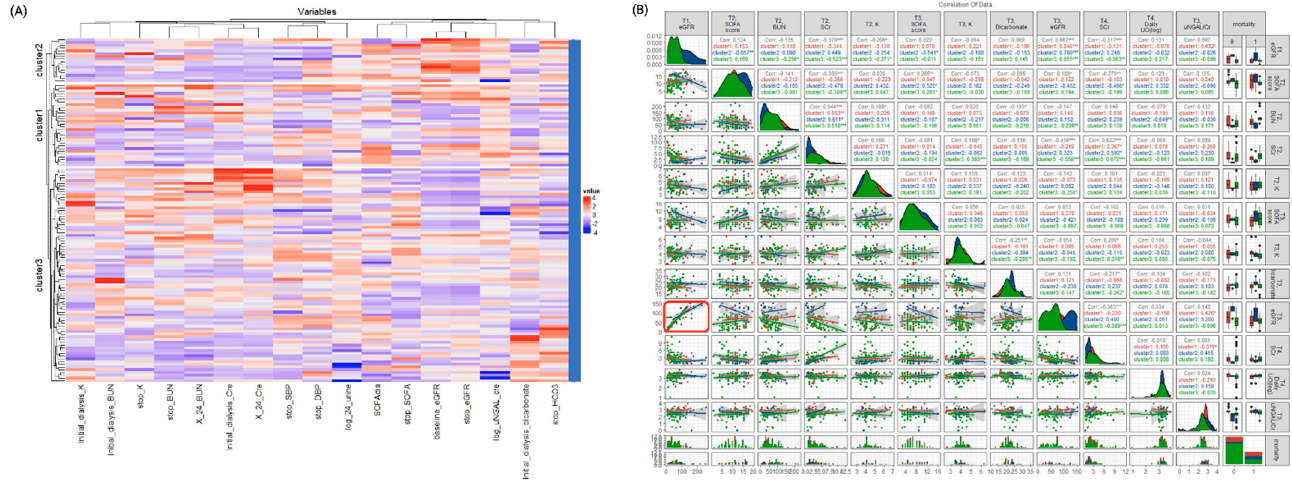
Figure 2. ( A ) The heatmap shows the three subtypes according to the selected baseline parame- ters. The dendrogram on the y axis shows consensus clustering of the patients. The x axis shows the variables of the patients attempting to wean from RRT. ( B ) Correlations between baseline predictors with overall mortality. Generalized pairs plot depicting all of the pairwise scatter plots comparing scores of each pair of selected predictors (upper diagonal), and the regression line (lower diagonal). Each plotted point represents a study participant. Distributions and plots are based on values for the area under the positive part of the curve which are displayed on the axes; the shaded areas show 95% confidence intervals, and significant differences are represented by asterisks. Red boxes represent significant correlations of baseline eGFR and eGFR when stopping dialysis. Abbre- viations: BUN, blood urea nitrogen; Cr, Creatinine; eGFR, estimated glomerular filtration rate; NGAL, neutrophil gelatinase-associated lipocalin; RRT, renal replacement therapy; sCr, serum cre- atinine; SOFA, Sequential Organ Failure Assessment; UO, urine output.